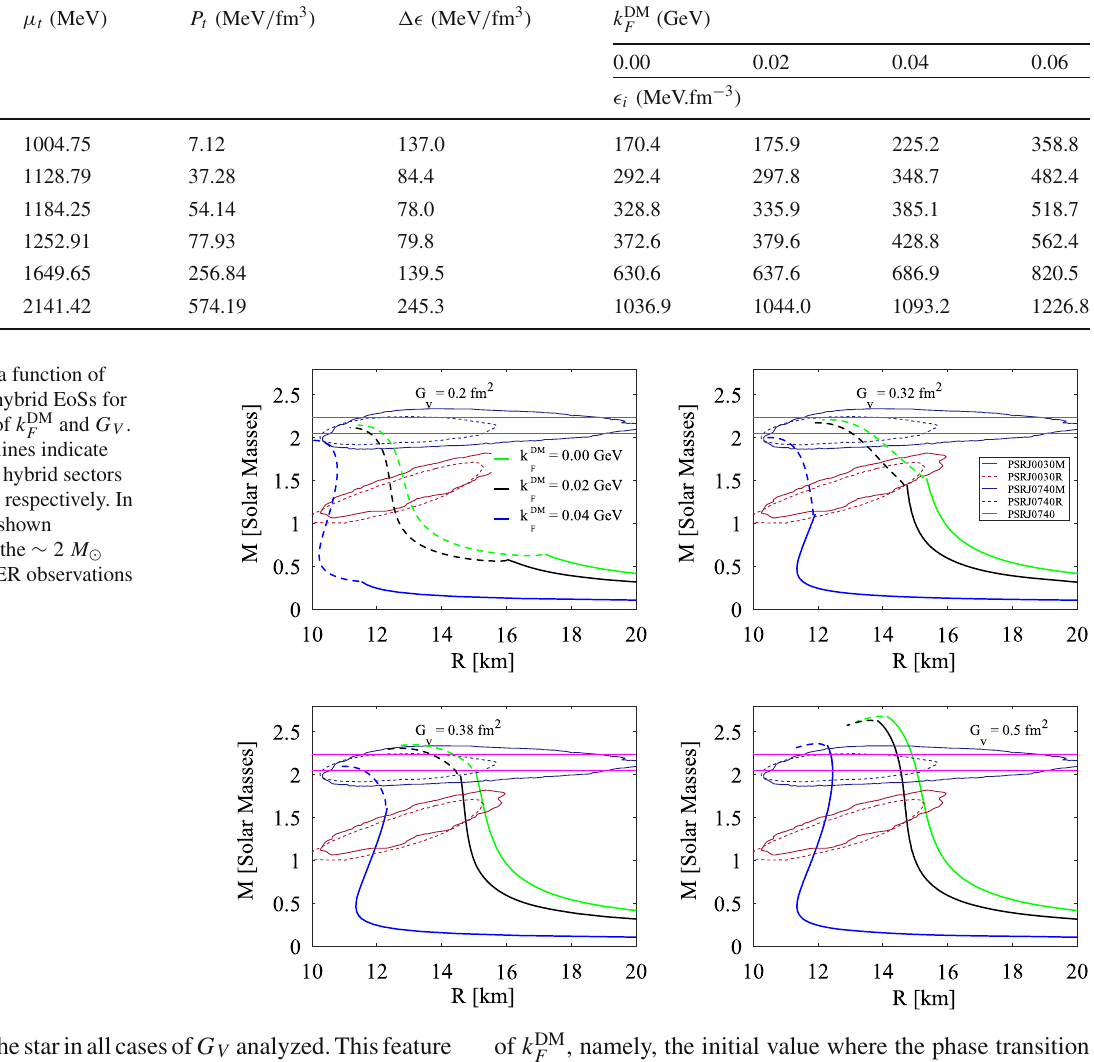
model, G V , and dark matter Fermi momentum, k DM matter contribution is relevant only for the initial energy density, (cid:14) i i , related to